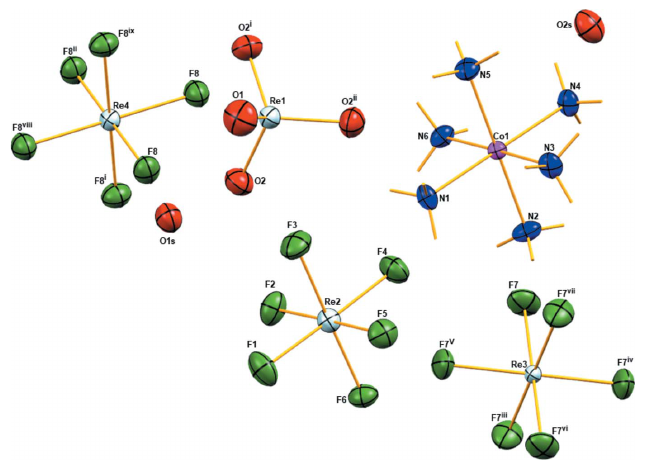
Figure 1 The molecular structure of ( I ) showing displacement ellipsoids drawn at the 50% probability level for all non-H atoms. Symmetry codes: (i) 1 (cid:3) x + y , 1 (cid:3) x , z ; (ii) 1 (cid:3) y , x (cid:3) y , z ; (iii) 1